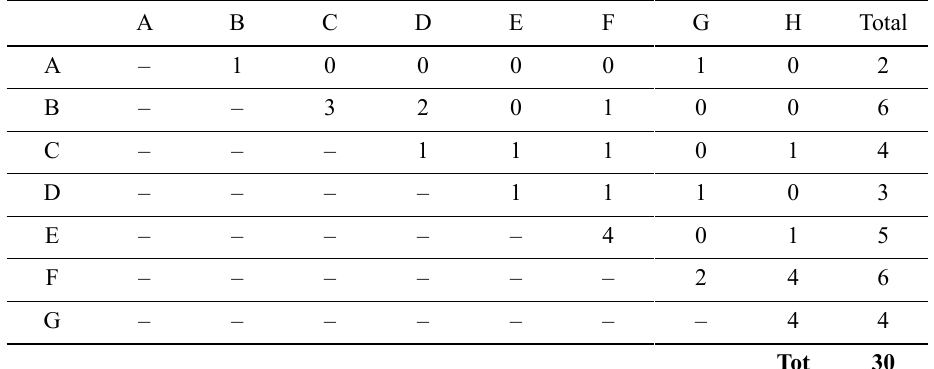
Table 5. “Matrix of common